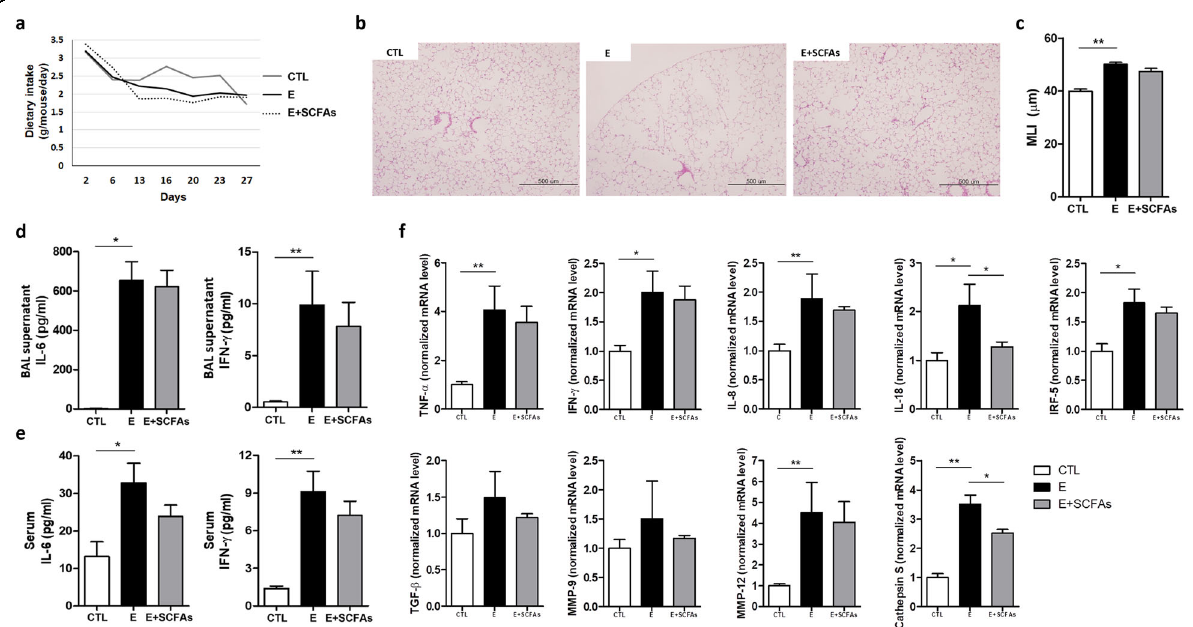
Fig. 5 SCFA supplementation decreased the in fl ammatory response and emphysema (Experiment 4). a Dietary intake changes during the 4 weeks of the experimental period. b Representative H&E-stained lung tissues from mice in the control, emphysema, and emphysema with SCFA supplementation groups (magni fi cation: 100×). c The MLI of lung tissues from each group. d, e The levels of the cytokines IL-6 and IFN- γ in the BALF ( d ) and serum ( e ) measured using ELISA. f The relative mRNA levels of TNF- α , IFN- γ , IL-8, IL-18, IRF-5, TGF- β , MMP-9, MMP-12, and Cathepsin S in the lung tissue ( n = 5 mice per group; n = 4 control mice for IL-6 analysis in BALF). Values are expressed as the mean ± SE. * P < 0.05 and ** P < 0.01. CTL control, E